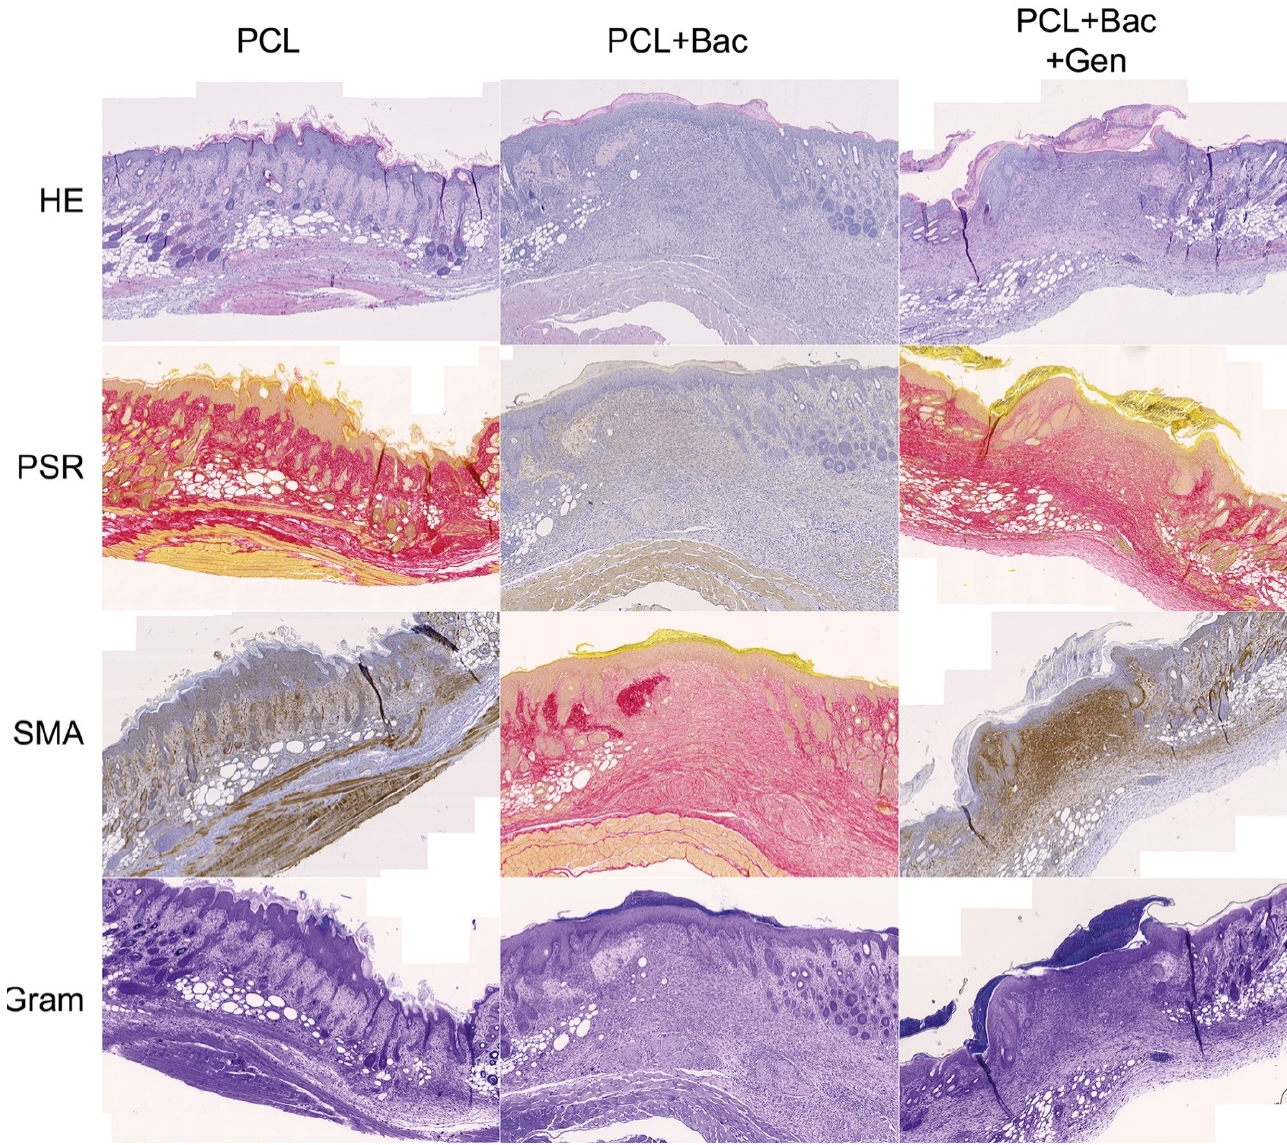
Figure 14. Newly formed skin, tissue 5 × 3.33 cm, scale bar 500 μ m. PCL—polycaprolactone, Bac— induced bacterial infection by S. aureus and P. aeruginosa , Gen—gentamycin, HE—haematoxylin–eosin, PSR—picrosirius red, and SMA—smooth muscle actin alpha.